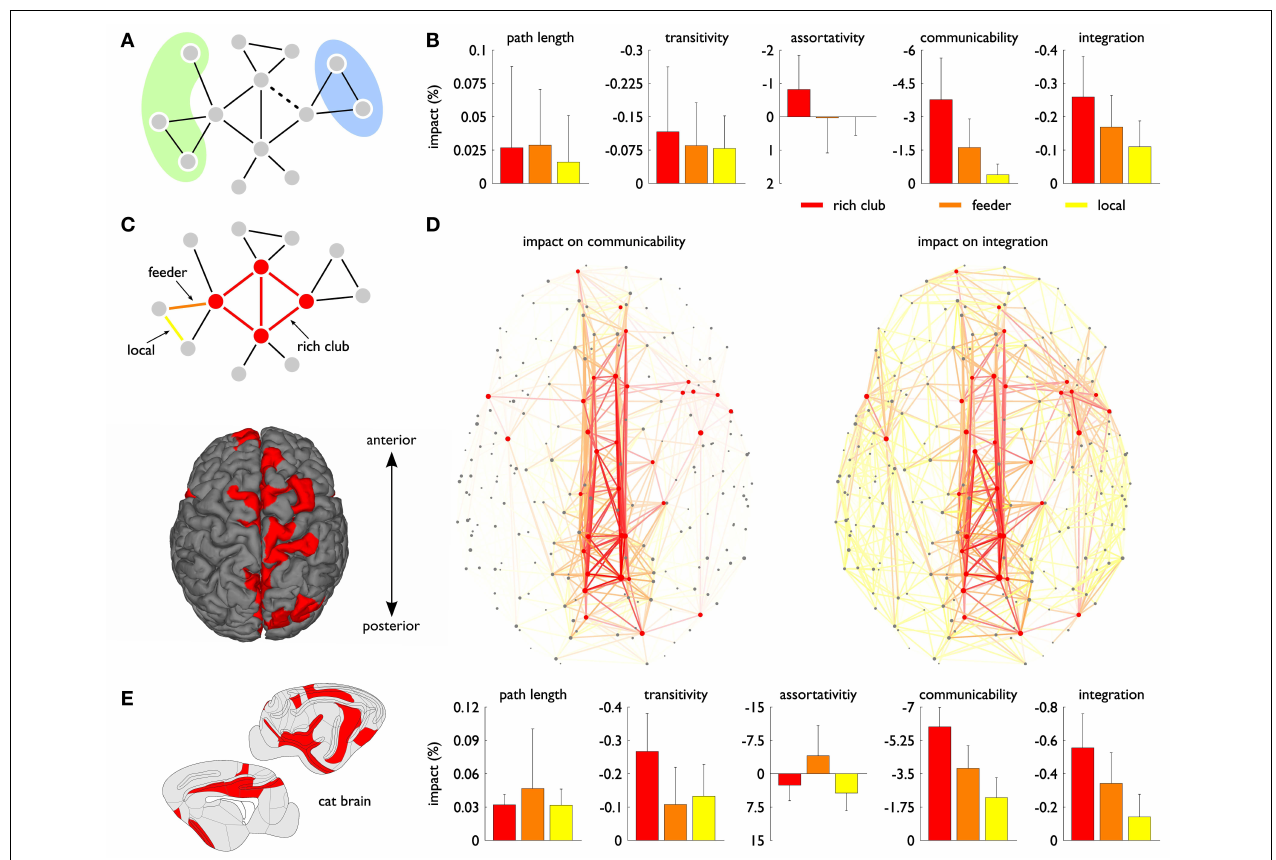
classes illustrated in panel (C) : “rich club” connections between (red) rich club nodes, “feeder” connections between rich club and (gray) non-rich club nodes and “local” connections between non-rich club nodes. (D) Network plots showing the importance of individual connections for the network’s communicability and functional integration. Removal scores are reflected by the transparency of connections, the most important connections being the most opaque. Underscoring the visual concentration of crucial edges around rich club nodes, the vast majority of rich club connections (86%) was found to belong to the 30% connections with the highest impact on communicability. (E) Validation on the basis of a tract-tracing reconstruction of the cat connectome revealed highly similar results, again showing a pronounced role of rich club connections in global communication and functional